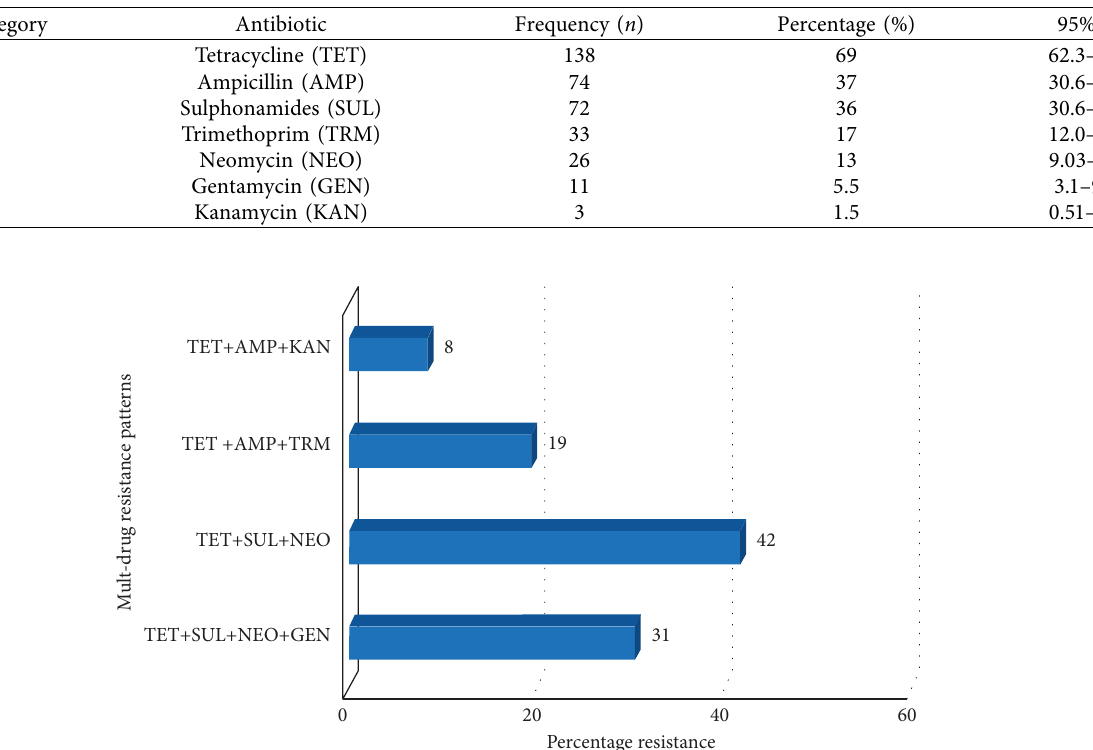
Figure 2: Common diseases and conditions on farms. Table 5: Overall AMR of E. coli isolates to selected drugs.